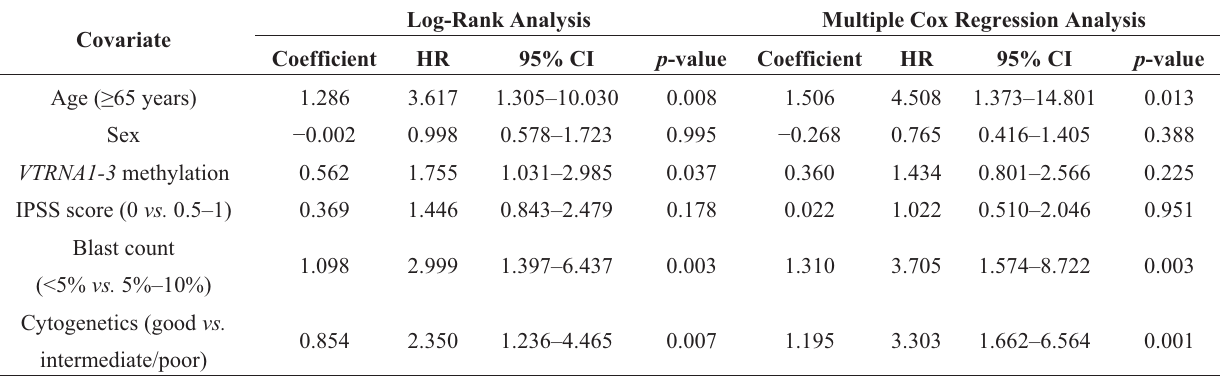
Table 2. Log-rank analysis for individual variables (covariates) and multiple Cox-regression analysis of all the included